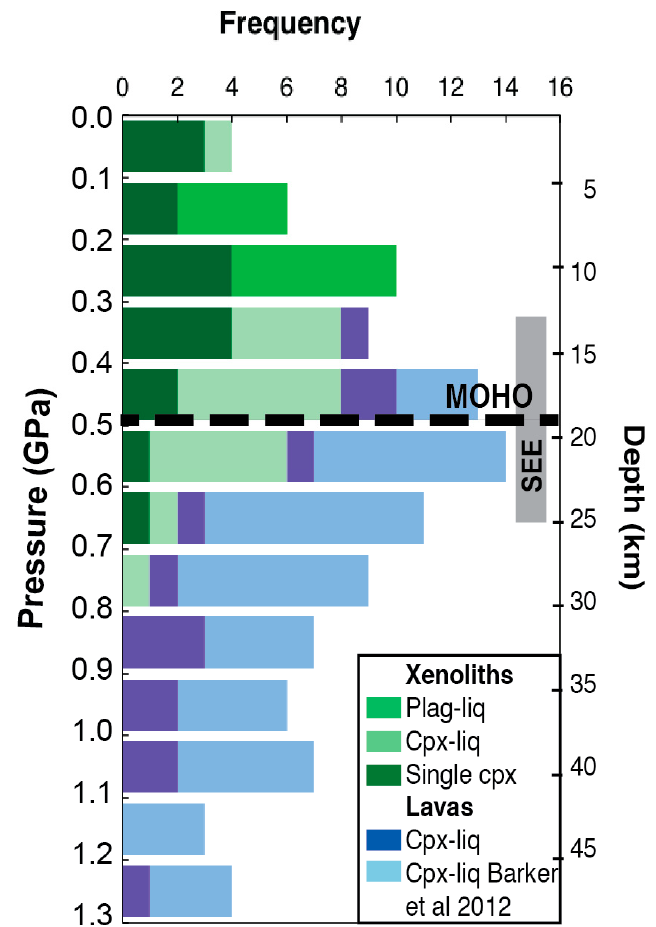
Figure 6. Pressure and depth profile for clinopyroxene and plagioclase from lavas and xenoliths from Cape Verde. Clinopyroxene-melt, single clinopyroxene and feldspar-melt thermometers were used for thermobarometric calculations [13,22,23]. Clinopyroxene crystallization in the lavas occurred dominantly at pressures of ≥ 0.5 GPa, originating from below the Moho, hence crystallization of the lavas occurred in the oceanic lithospheric mantle [4]. The majority of clinopyroxene and plagioclase in the xenoliths crystallized between 0.2 and 0.4 GPa, above the Moho in the oceanic crust. The Moho was determined to be 18 ± 1 km at Cape Verde [43]. The uncertainty for clinopyroxene-liquid pressure estimates is ± 0.17 GPa (standard error of estimate; SEE) shown by the grey bar. Additionally single clinopyroxene pressure estimates are associated with ± 0.15 GPa SEE and plagioclase-liquid thermobarometry with ± 0.25 GPa SEE [13]. See Supplementary Figure S1 for